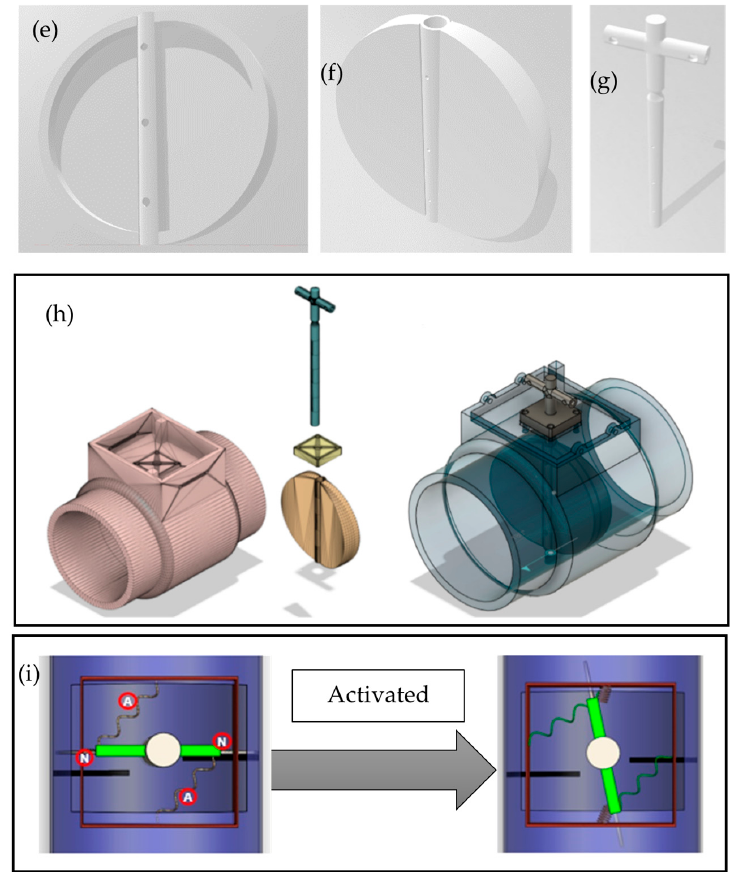
Figure 2. Design of the valve consisting of ( a ) the main body of the valve, ( b ) the top side of the main body, ( c , d ) the top and bottom side of the top cap, respectively, ( e , f ) both sides of the disc, ( g ) the actuation rod, ( h ) the full valve setup, and ( i ) spring connection and activation system.